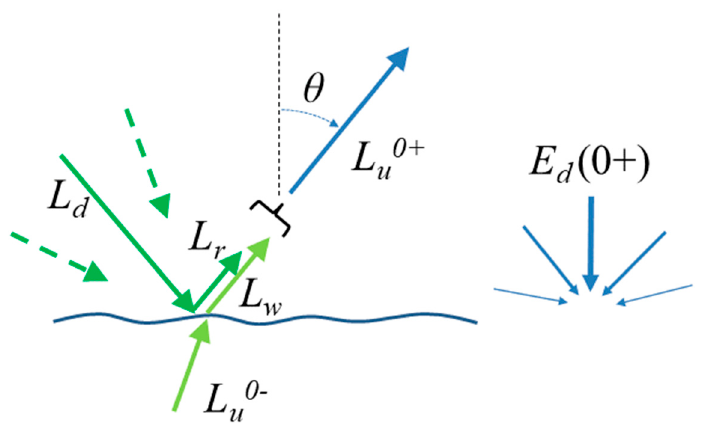
Figure 2. Illustration of definitions of water-leaving radiance, L w , above and below water upwelling radiances, L 0 + u and L 0 − u , above-water downwelling (sky) radiance in the specular reflection direction, L d , above-water upwelling radiance from reflection at the air–water interface (“skyglint”), L r , and downwelling irradiance, E 0 + . See also [4]. The widths of the arrows for E 0 + represent the zenith cosine weighting for the di ff erent incident angles.